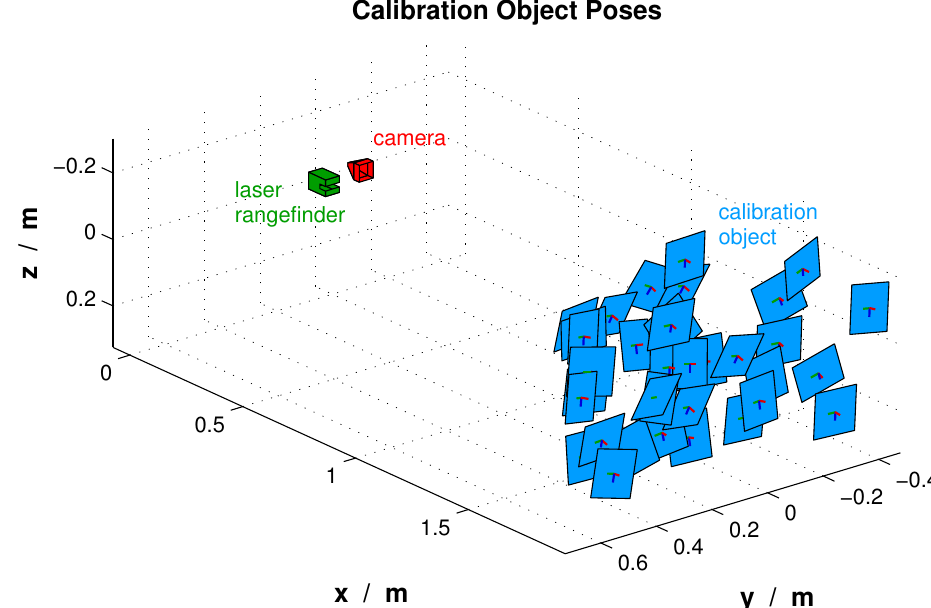
Figure 8. Various calibration poses for the 3D-to-2D correspondences.